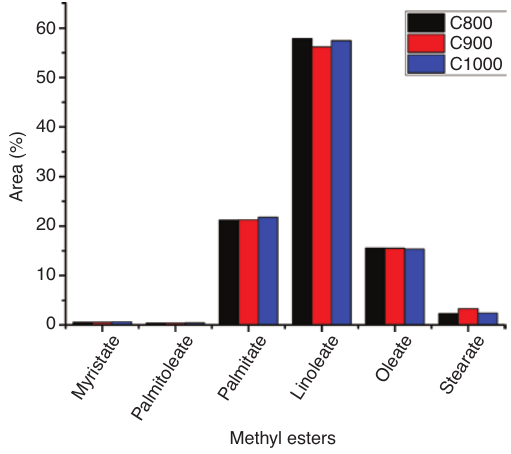
Figure 5: Chemical composition of methyl esters in prepared cottonseed oil using calcium oxide at different temperatures, areas obtained by chromatographic analysis in gas chromatography with flame ionization detector (GC-FID).